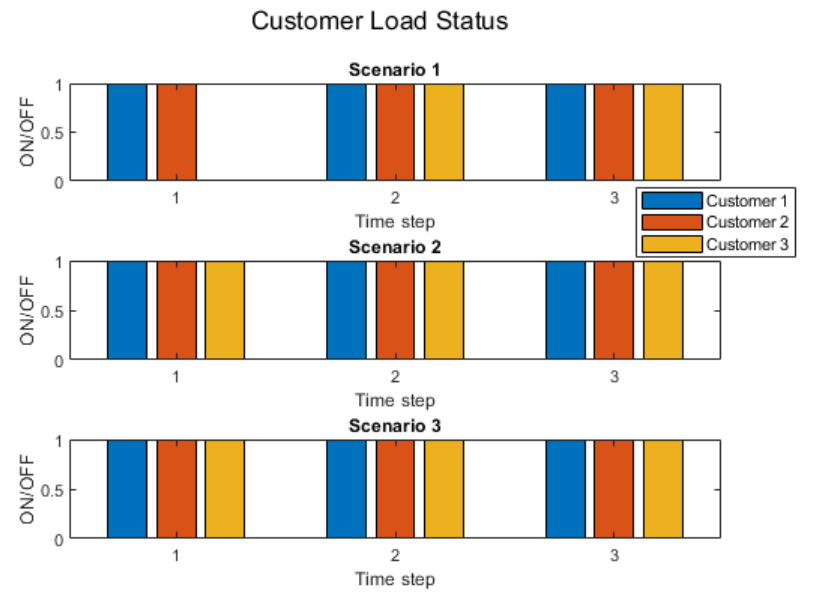
Figure 4. Load shedding or shifting instances during all three scenarios. During scenarios 2 and 3, there is sufficient generation to meet the demand; therefore, no load shedding or shifting is performed. However, during scenario 1, customer 3 experiences a load shed for time-step 3 (although not during times 1 or